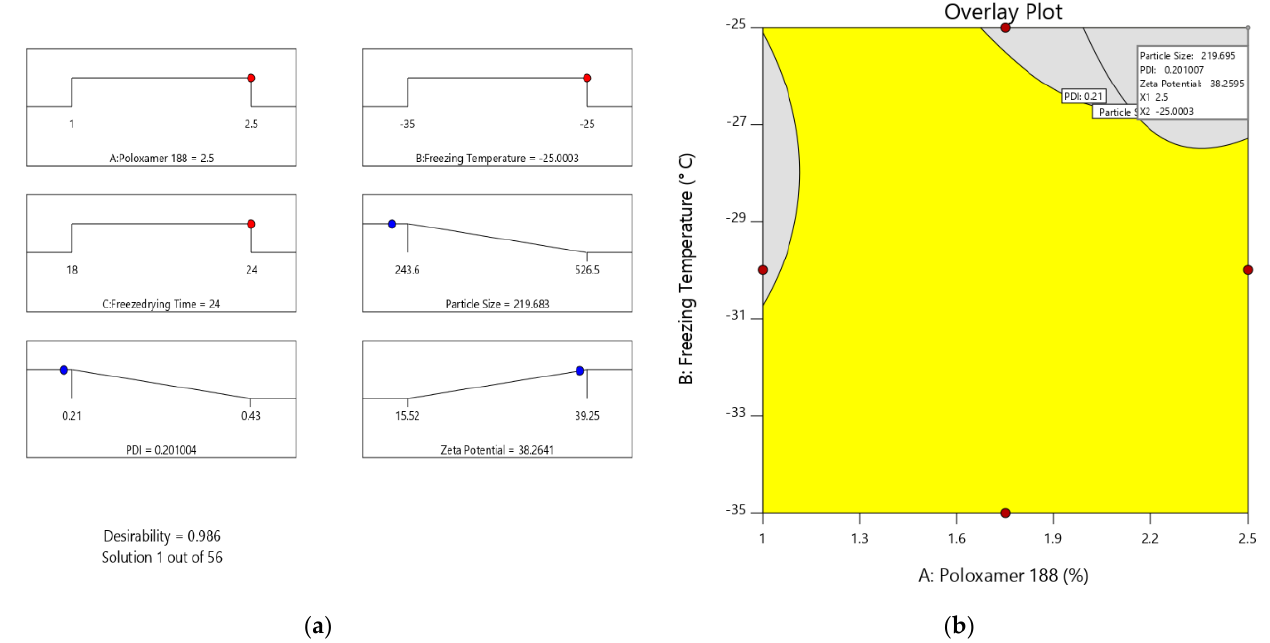
Figure 5. ( a ) Ramp chart and ( b ) overlay of optimization result. (Red color dots represents optimized concentrations of selected variables and blue dots represents for optimized result of chosen responses). Table 5. Post compression parameters for VNM and F-VS.